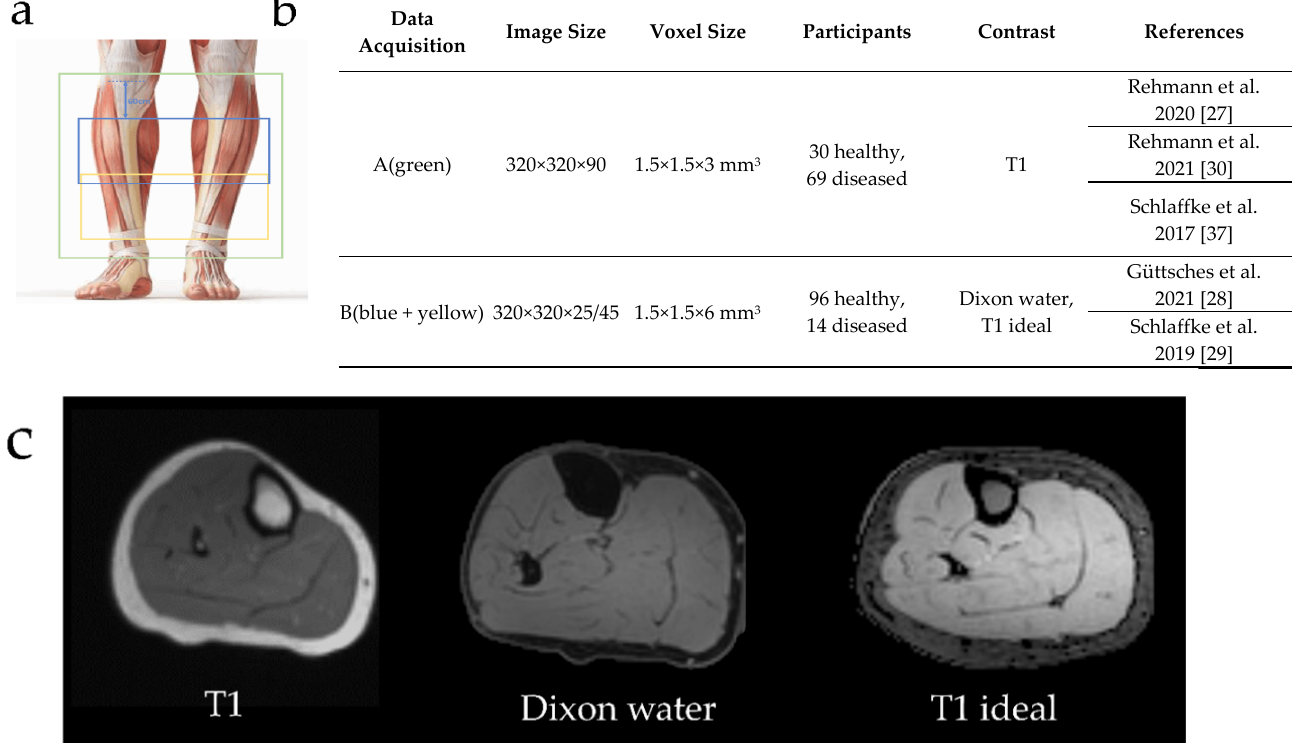
Figure 1. Overview of the diversity of MR-images included in the database. a: The data acquisitions differ in their field-of-view. The green rectangle represents a field-of-view for data acquisition (A) with 90 slices in the z-axis, while the blue and yellow rectangles (B) show the 25 and 45 slices from data acquisition, respectively, measured 60 cm ventral from the tibial plateau. b: Comparison between data acquisition (A) and (B) regarding image size, voxel size, participants and contrasts. c: Three different types of contrasts are included in the database.